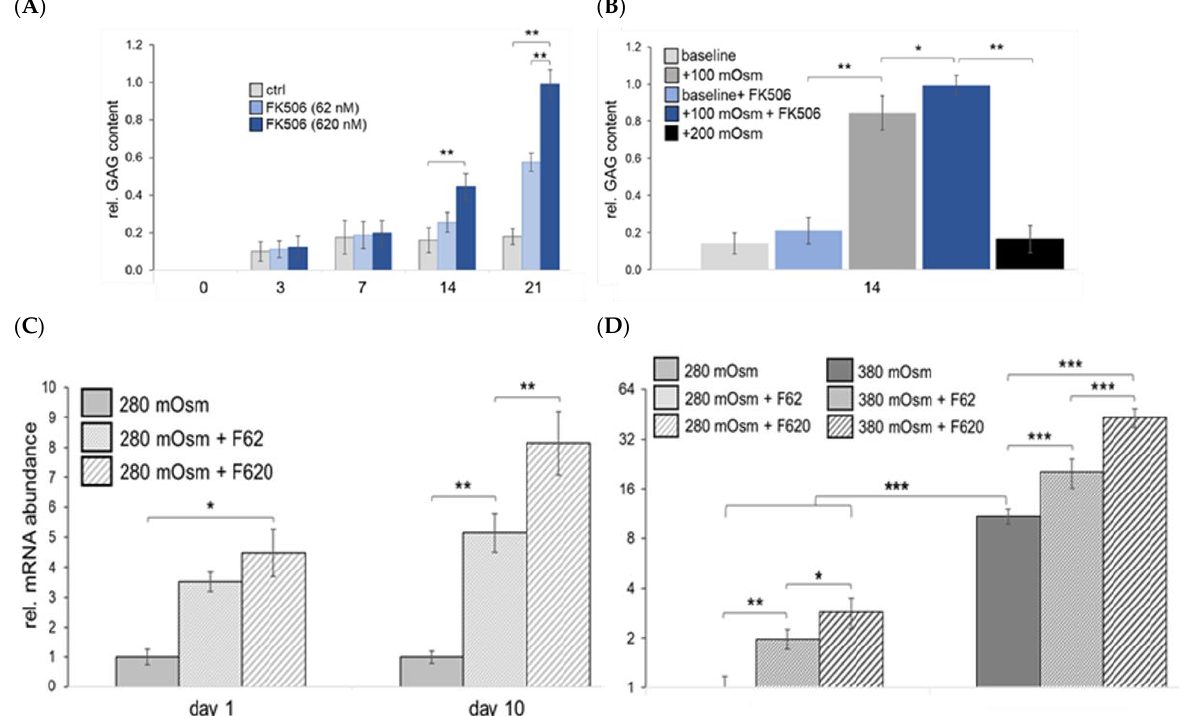
Figure 3. FK506 dose-dependently stimulates glycosaminoglycan and collagen synthesis in physos- motic ATDC5 cultures. ( A ) During chondrogenic differentiation, from day 14 on, FK506